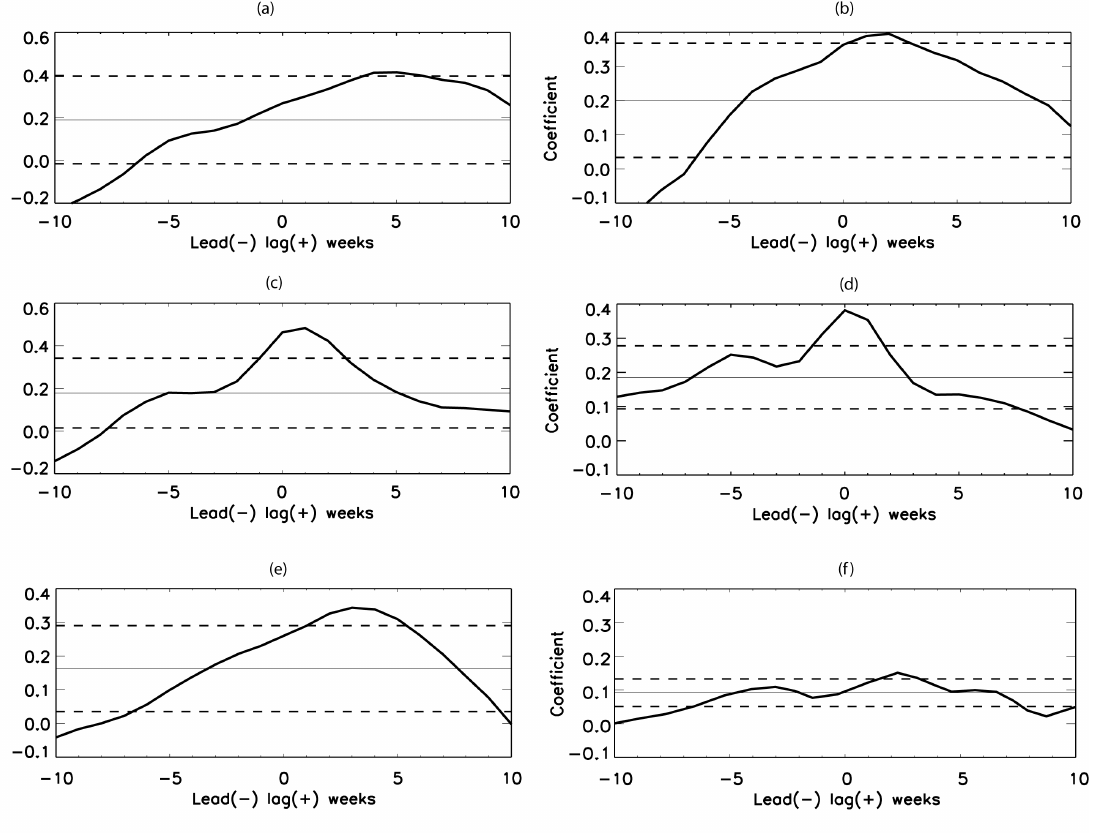
Figure 3. Lead–lag correlation between SIF and precipitation ( a , b ), precipitation and soil moisture ( c , d ), and SIF and soil moisture ( e , f ) for US-Ne3 ( a , c , e ) and US-KFS ( b , d , f ) stations respectively. Dashed lines denote the 95% confidence